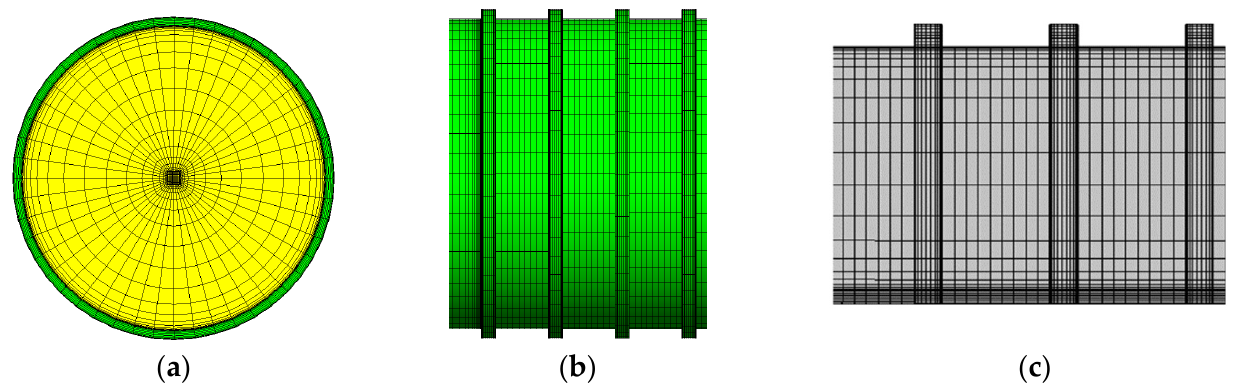
Figure 3. The grids for numerical analysis ( a ) Pipe inlet, ( b ) the pipe wall, ( c ) in the corrugated